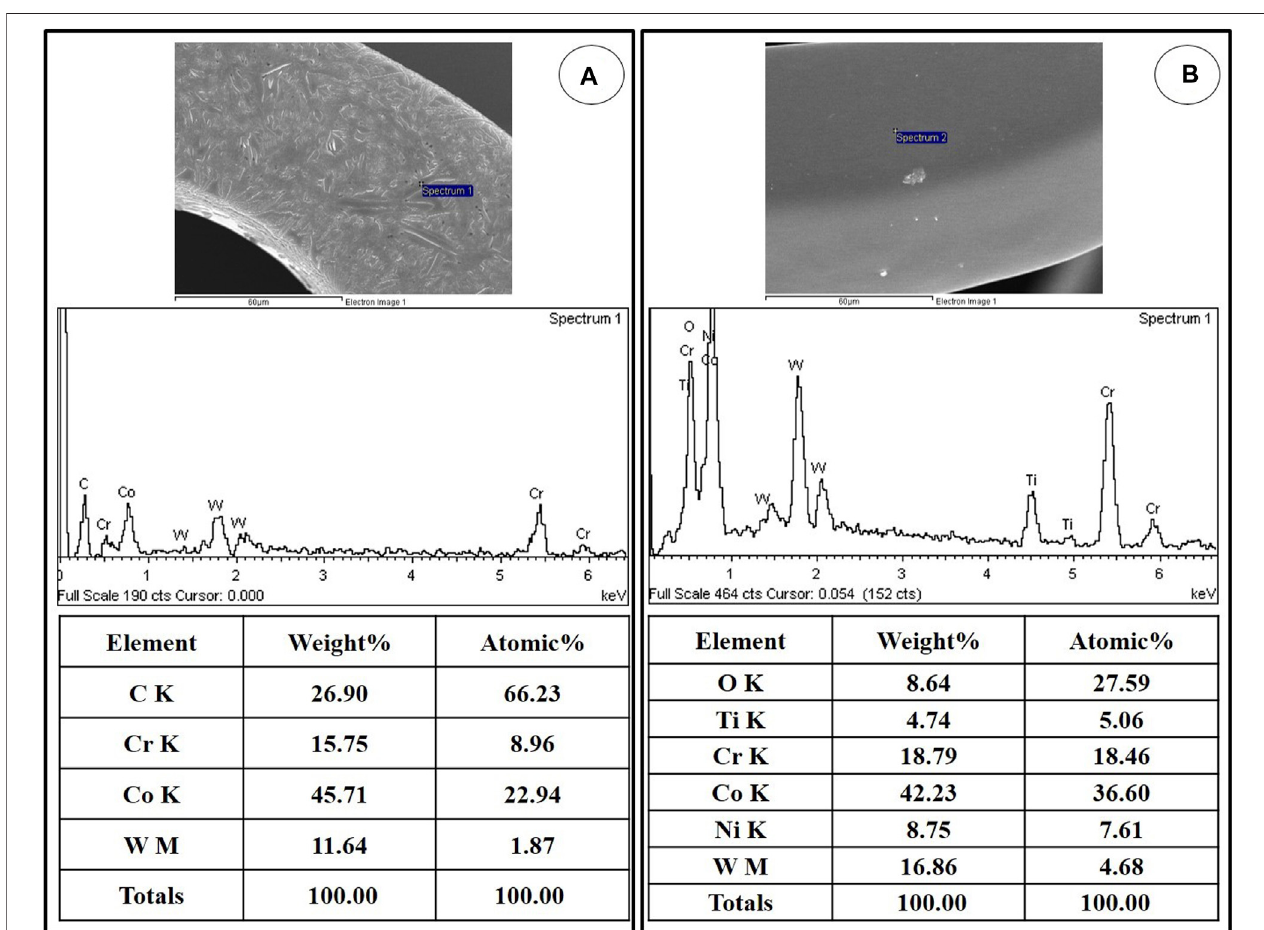
FIGURE 3 | Representative EDS spectra showing the surface composition of NTM (A) and NT (B) . EDS, Energy-dispersive X-ray spectroscopy; NTM, TiO 2 fi lm – coated stent with mycophenolic acid; NT, TiO fi lm – coated stent. 2